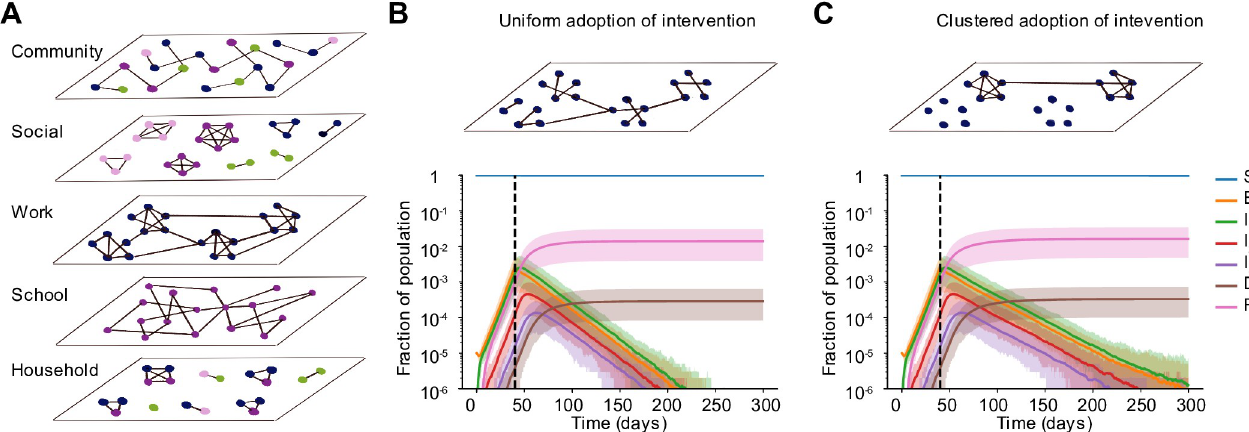
Fig 5. Clustered vs uniform adoption of social distancing measures. A) Schematic of the multi-layer network created to more realistically capture non- household contacts and how they are altered by social distancing measures. In each layer, the degree distribution and level of clustering were chosen to match data. The “community” layer represents any other contact not fitting in the other four categories. Colors of nodes represent four broad age groups that determine network membership and structure: preschool-aged (pink), school-aged (purple), working-aged (blue) and elderly (green). B)—C) Simulated time courses of infection in the presence of social distancing intervention with random (B) vs clustered (C) adherence to measures. In both cases, all school connections were deleted post-intervention and 85% of connections were uniformly deleted at random in the social and community layers. In B) 85% of work connections were uniformly deleted whereas, in C) 85% of workplaces were dissolved, leading to clusters of disconnected vs connected individuals in the work layer of the network. The effective intervention efficacy for all layers combined was ~ 88% in both scenarios. Black dotted line shows the time the intervention